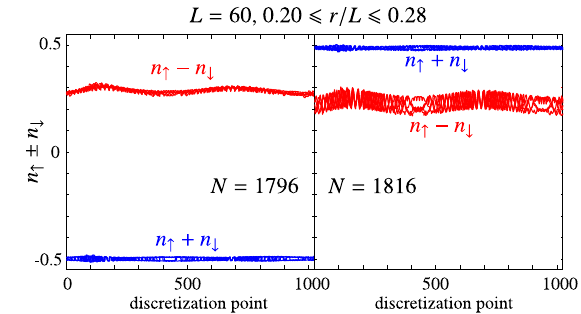
FIG. 10. Charge and magnetization of the vortex as it moves around another vortex in a system of L ¼ 60 for different